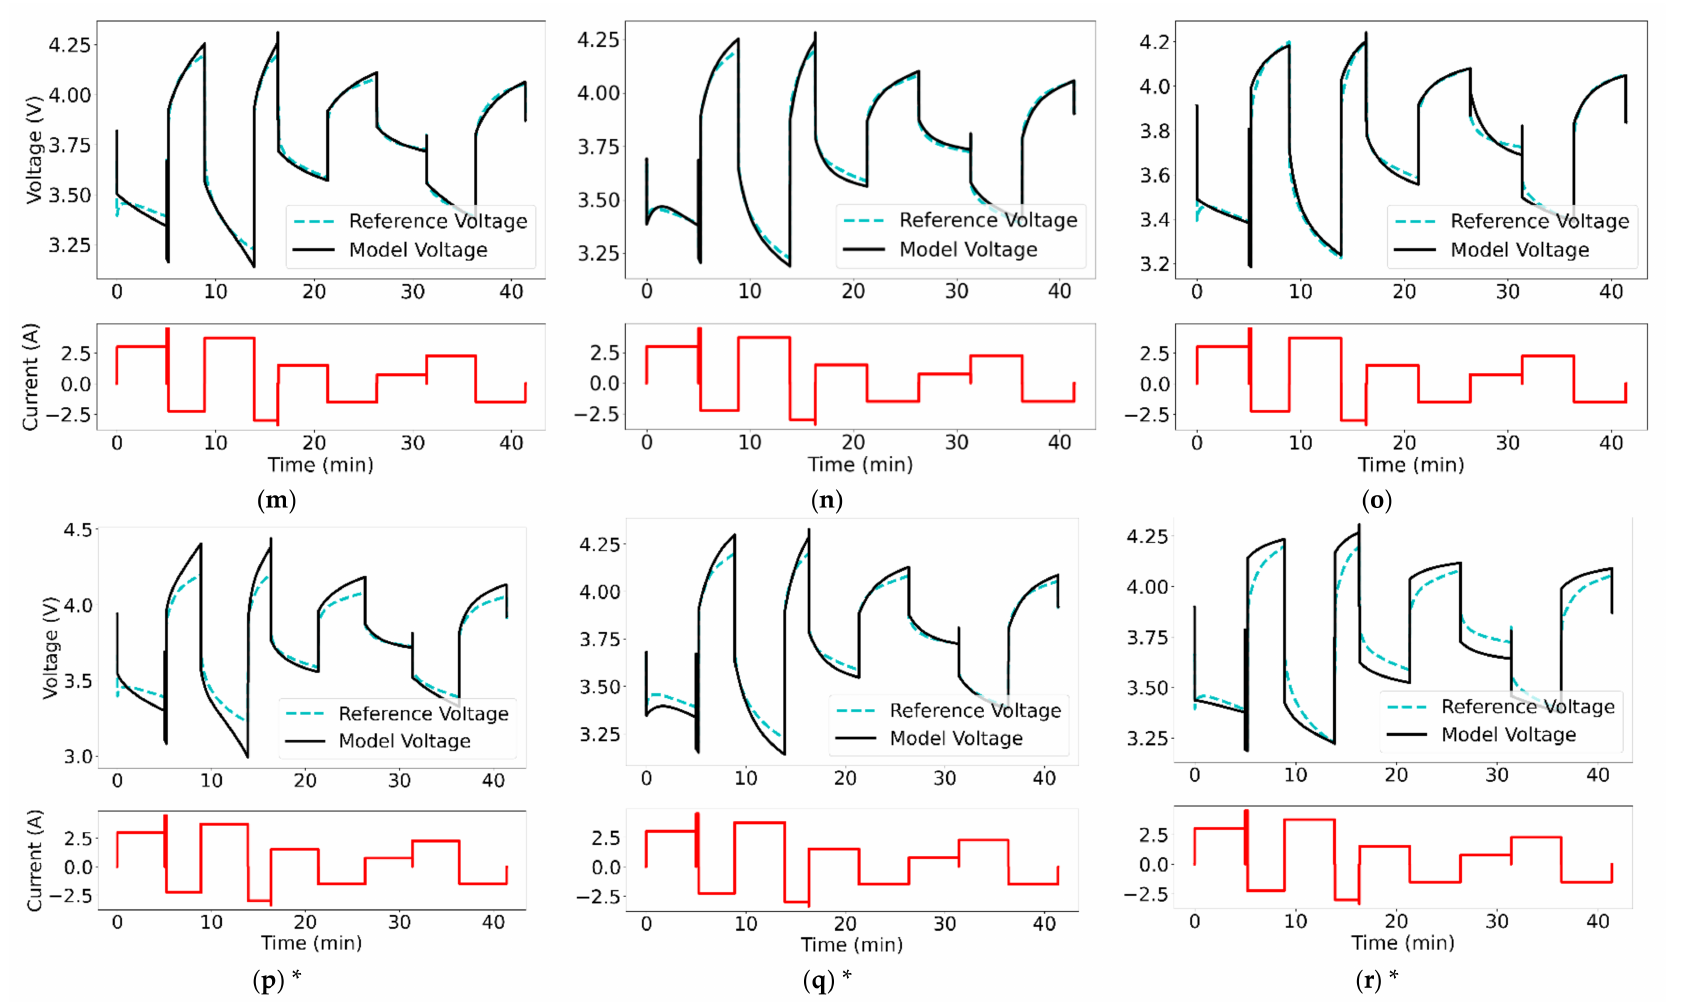
Figure 8. ( a – c ) Charge test; ( d – f ) Pulse Charge test; ( g – i ) Discharge test; ( j – l ) Pulse Discharge test; ( m – o ) Alternating use test; ( p – r ) Alternating use test *. * Model calibrated without alternating